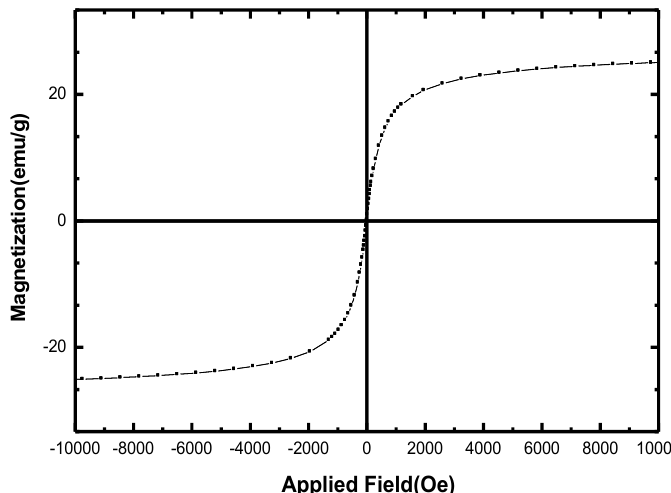
Fig. 7. Hysteresis curve of CuFe